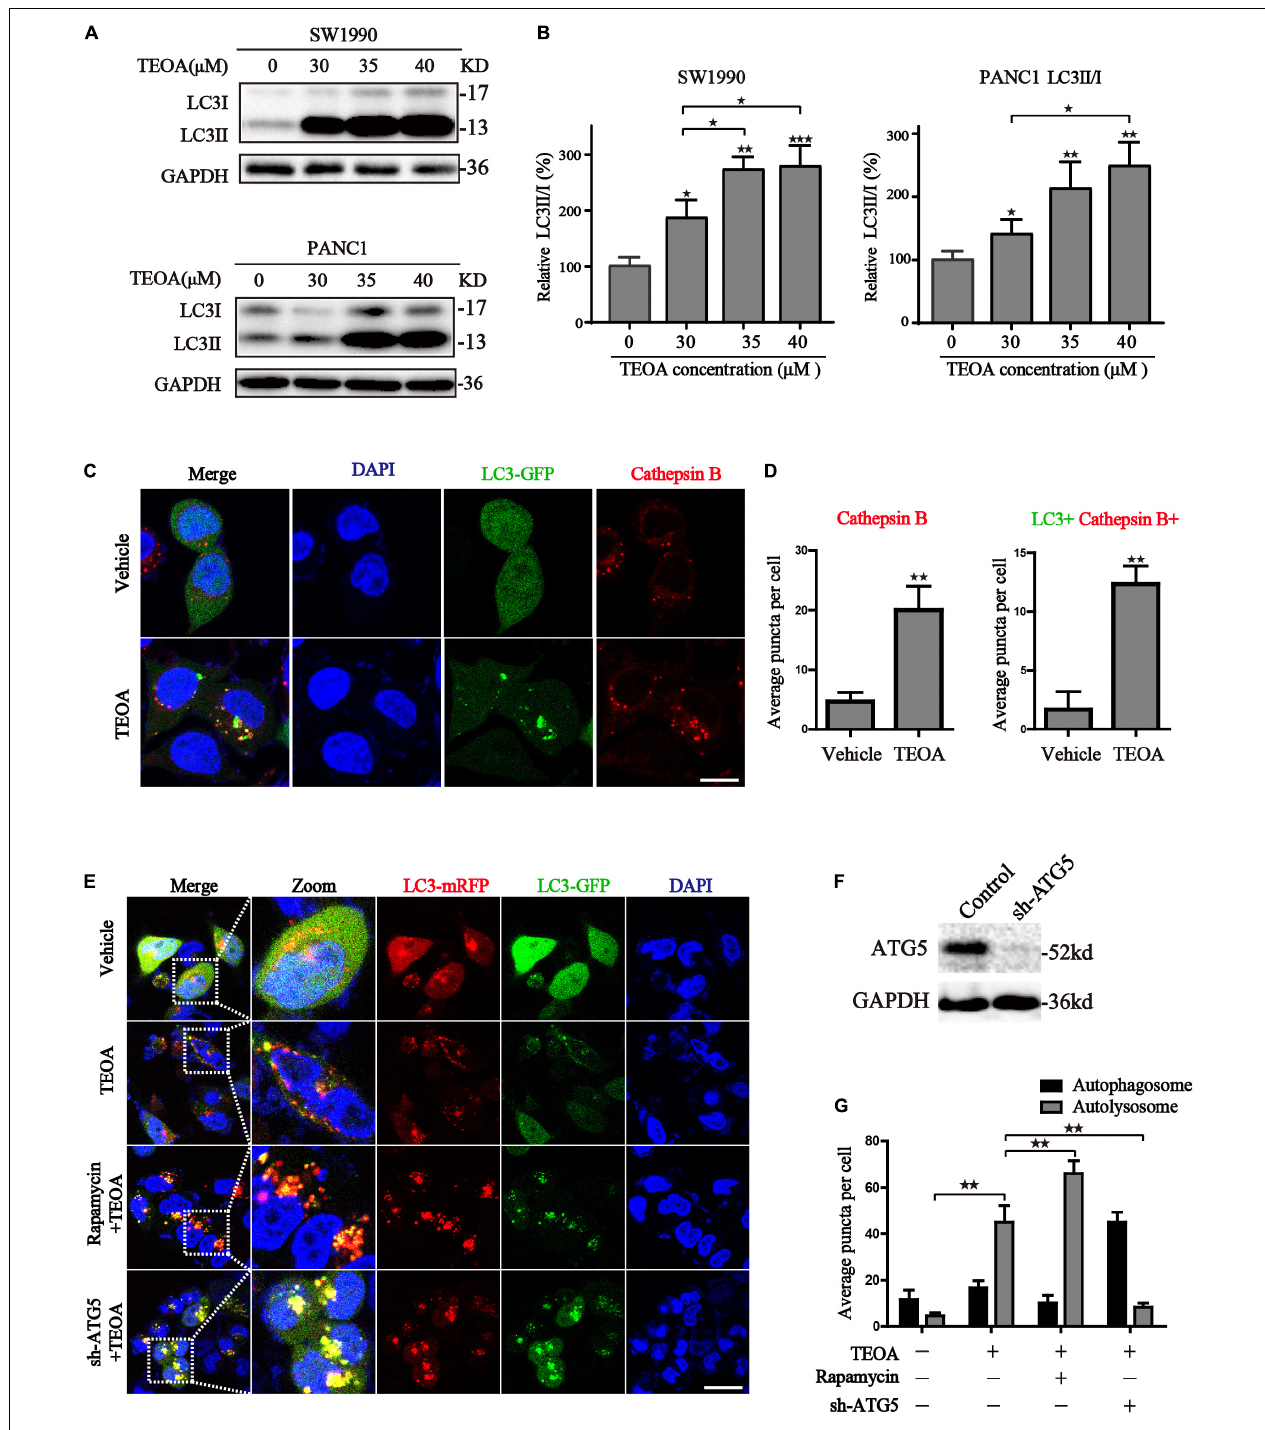
FIGURE 5 | TEOA induced autophagy in pancreatic cancer cells. (A) SW1990 and PANC1 cells were treated with TEOA at the indicated concentration of TEOA for 8 h and the ratio of LC3I and LC3II were detected by western blot. (B) The quantitations of LC3II/I were shown on the right. (C) SW1990 cells transfected with GFP-LC3 were treated with TEOA for 8 h and then stained with cathepsins, the changes of fluorescence were photographed by confocal microscopy. (D) Quantitative analysis for the Cathepsins + /LC3+ Cathepsins+ puncta of cells. (E) Wide type and ATG5 shRNA-transfected SW1990 cells were treated with TEOA alone or combined with Rapamycin (0.4 µ M) for 8 h following transfection with GFP-mRFP-LC3. Representative pictures were recorded using confocal microscopy, scale bar: 25 µ m. (F) SW1990 cells were transfected with control shRNA and ATG5 shRNA, respectively, and western blot was used to confirm the knock-down effects of ATG5. (G) Quantitative analysis for the autophagosomes and autolysosome ( (cid:70) p < 0.05; (cid:70)(cid:70) p < 0.01; (cid:70)(cid:70)(cid:70) p < 0.001, versus control).